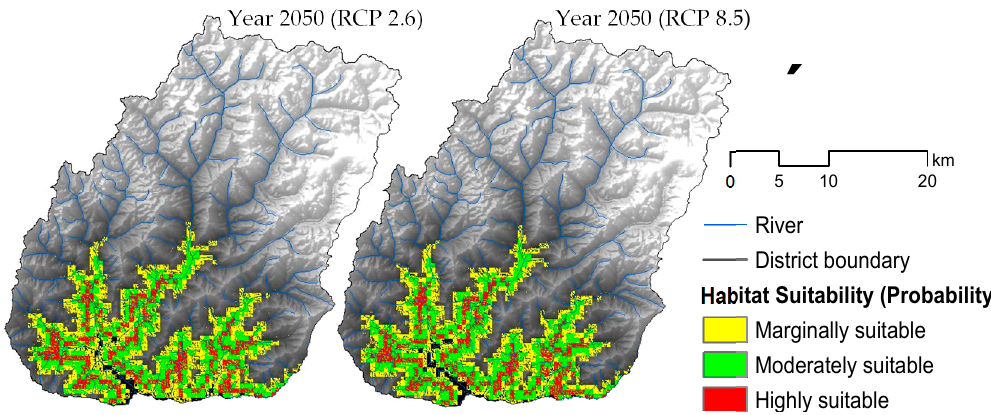
Figure 8. Distribution of large cardamom in Taplejung, Nepal, under future scenarios.